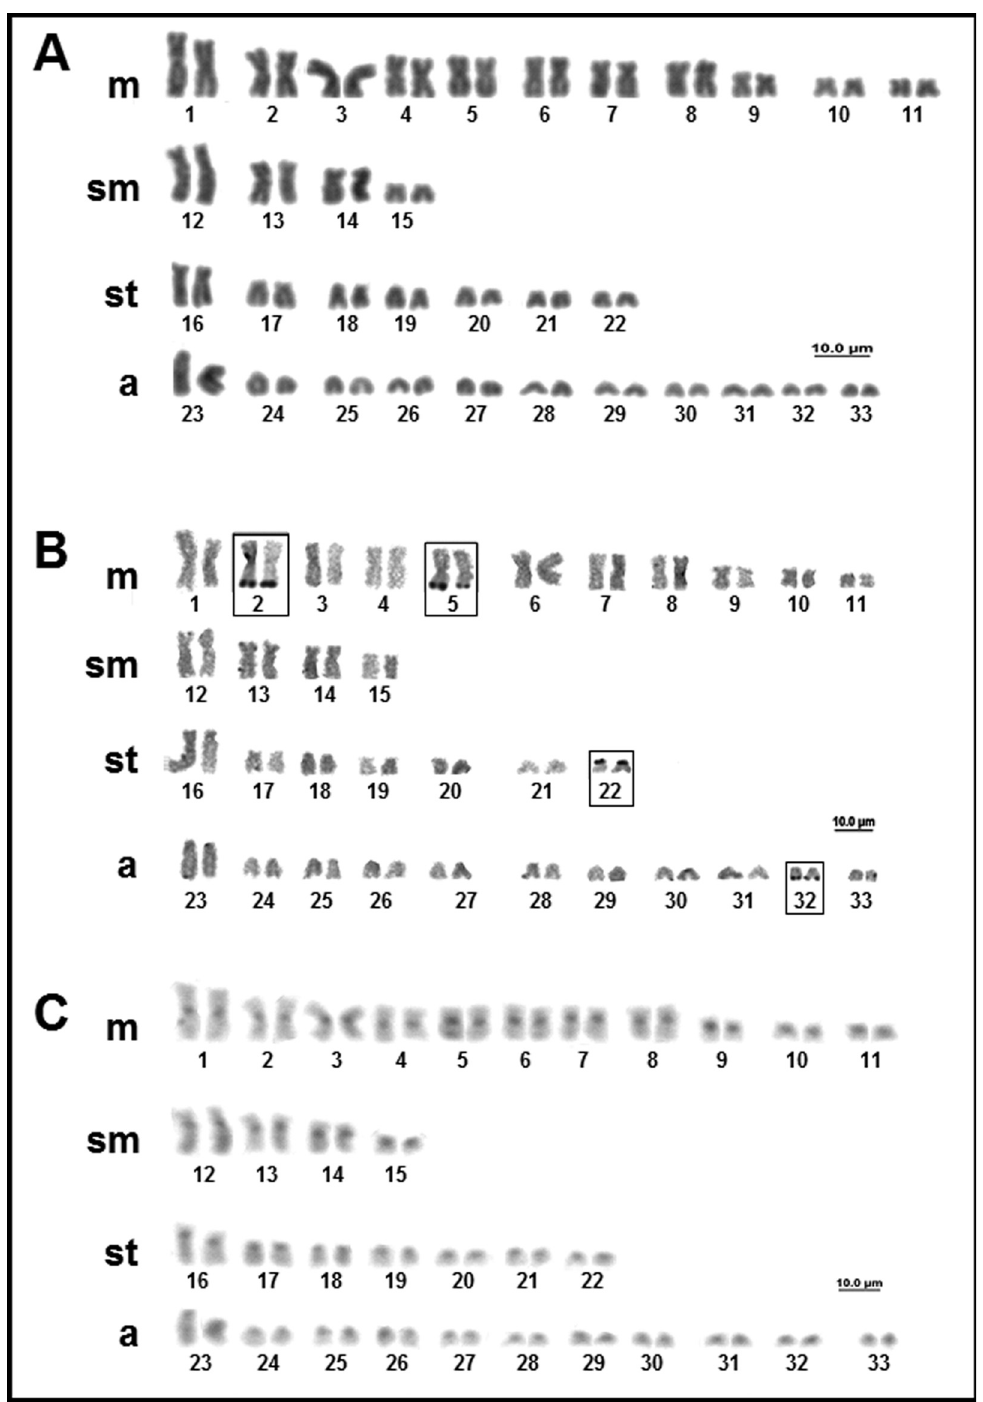
Figure 4 - Karyotype of Potamotrygon constellata (female): (A) conventional Giemsa staining; (B) AgNO 3 ; (C)